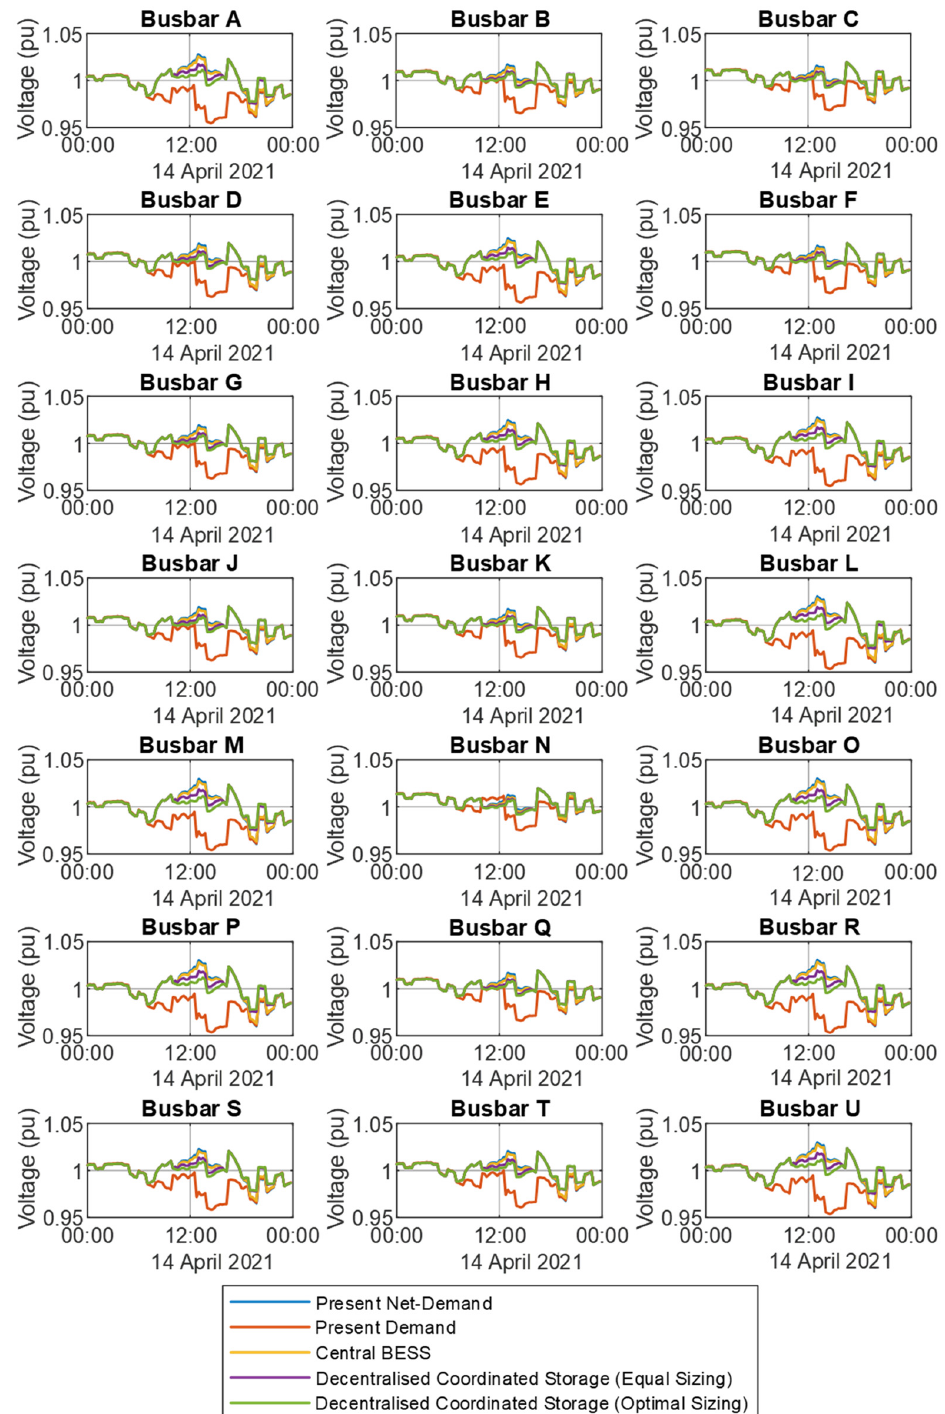
Figure 11. Simulated voltage profiles at the 11 kV side of the Xewkija DC transformer for all five case scenarios.